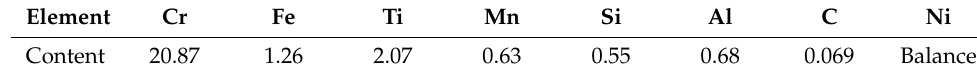
Table 1. Chemical composition of the studied Ni80A superalloy (wt. %).